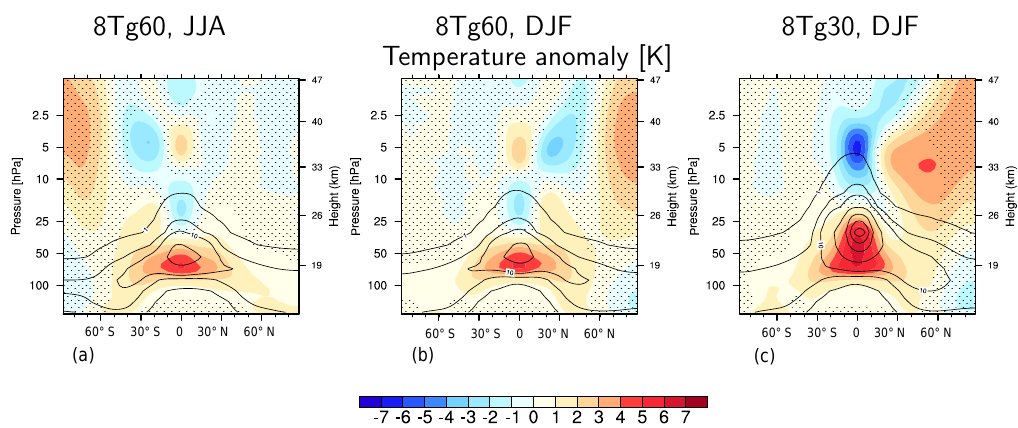
Figure 2. Zonal mean temperature anomaly for injection of 8Tg ( S ) yr − 1 at 60hPa (a, b) relative to control run at Northern Hemisphere summer (JJA, a ) and winter (DJF, b ) and DJF for an injection at 30hPa ( c ). Results are compared to a control simulation which includes different phases of the QBO. Stippling indicates areas which are not significant at the 95% level. Contour lines for sulfate aerosol mixing ratio [ppm] are plotted for 1, 5, 10, 25, 50, 75, 100ppm.